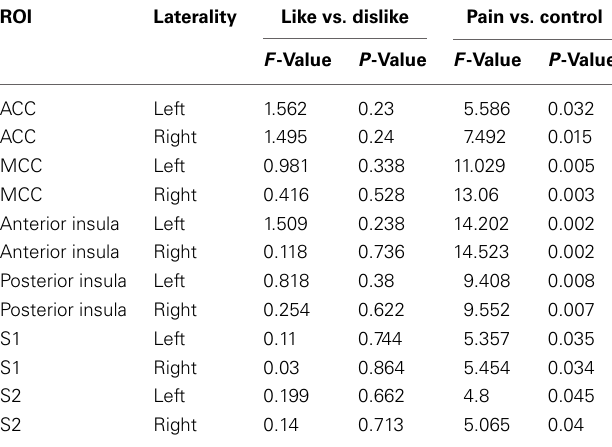
right anterior insula, right frontoparietal operculum, left sec- ondary somatosensory cortex, left superior temporal gyrus, right middle temporal sulcus, left precuneus, left amygdala, left and right putamen, and right nucleus accumbens. Greater functional connectivity while viewing likable people in pain compared with viewing hateful people in pain was found in right lateral occipi- tal cortex ( Figure 5 ). From the right insula seed, connectivity for viewing hateful targets in pain was found to the right and left thalamus, whereas viewing likable targets in pain revealed greater connectivity to the frontal pole, right IFG, left superior postero- medial cortex and right cerebellum. From the left insula seed, greater connectivity to viewing hateful targets in pain was found in the left MTG, and left posterior parietal cortices, whereas view- ing likable targets in pain revealed connectivity to the right